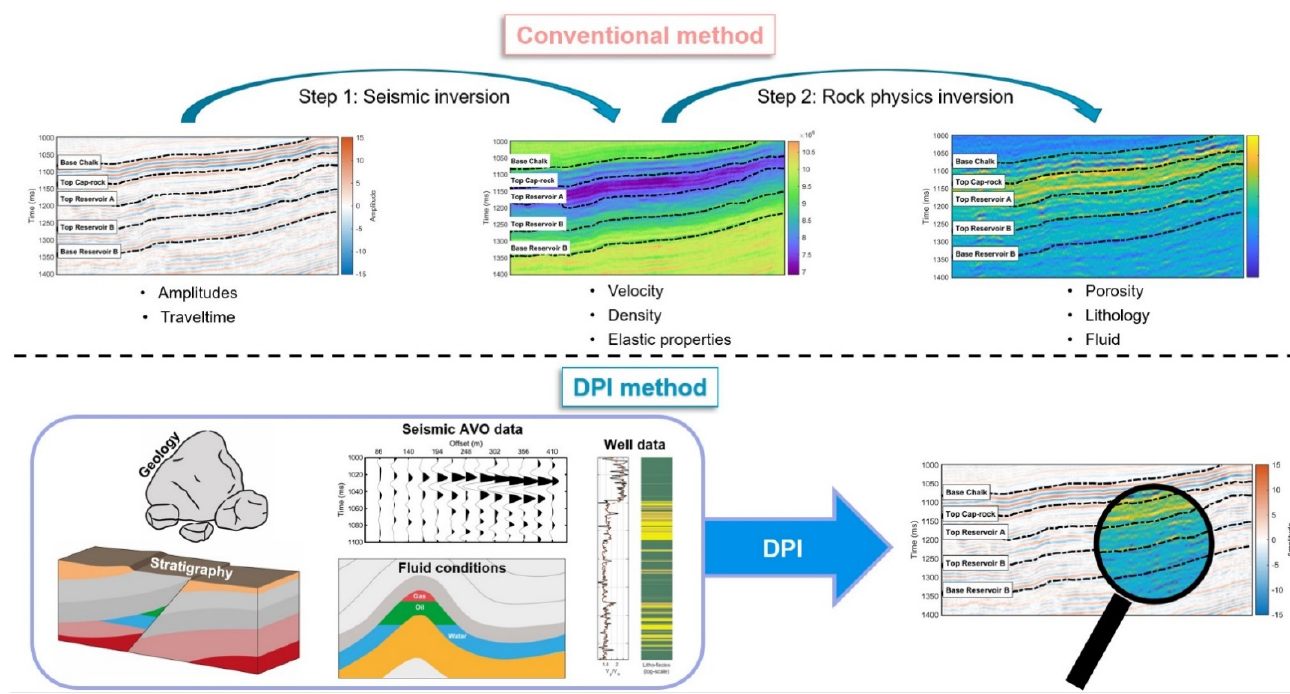
Figure 1. Schematic illustration of seismic inversion by the conventional two-step method ( upper ) and a one-step (direct) probabilistic inversion method ( lower ).